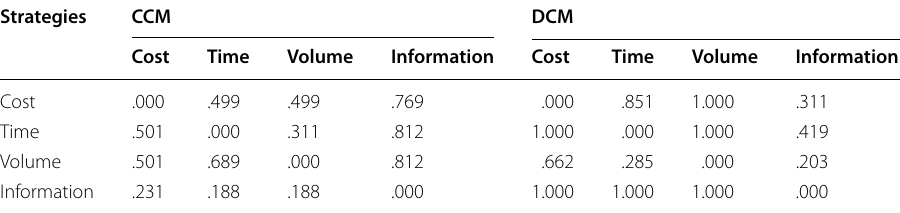
Table 16 CCM and DCM